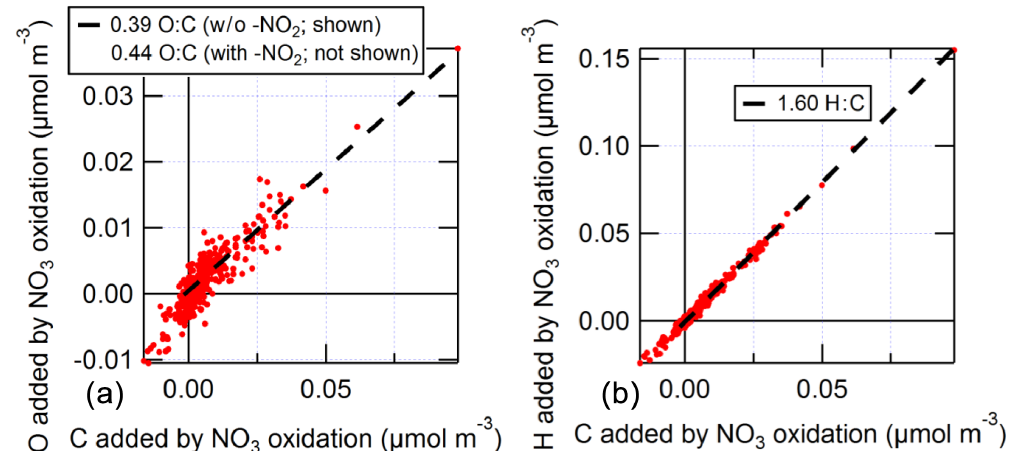
Figure 10. Scatter plots of µmolm − 3 O and µmolm − 3 H added per µmolm − 3 C added from NO 3 oxidation of ambient air in the OFR. The amount of O added is shown without including the O from the − NO 2 group, since those O atoms do not affect the oxidation state of C. The slopes show that the atomic O:C(H:C) ratio of the SOA mass formed was 0.39 (1.60). The slopes did not change with increasing NO 3 exposure. Contrary to Figs. 8–9, data are not colored by NO 3 exposure. The ranges of NO 3 exposure achieved during daytime vs. nighttime were unequal (Figs. 5–6, S12), obscuring any trend of OA enhancement vs. eq.